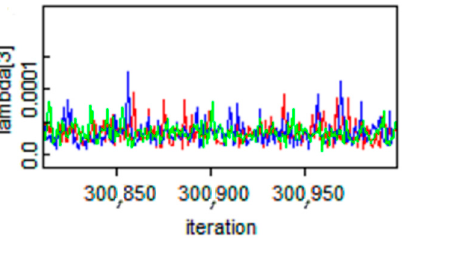
Figure 8. The dynamic trace of λ in the MCMC modeling.